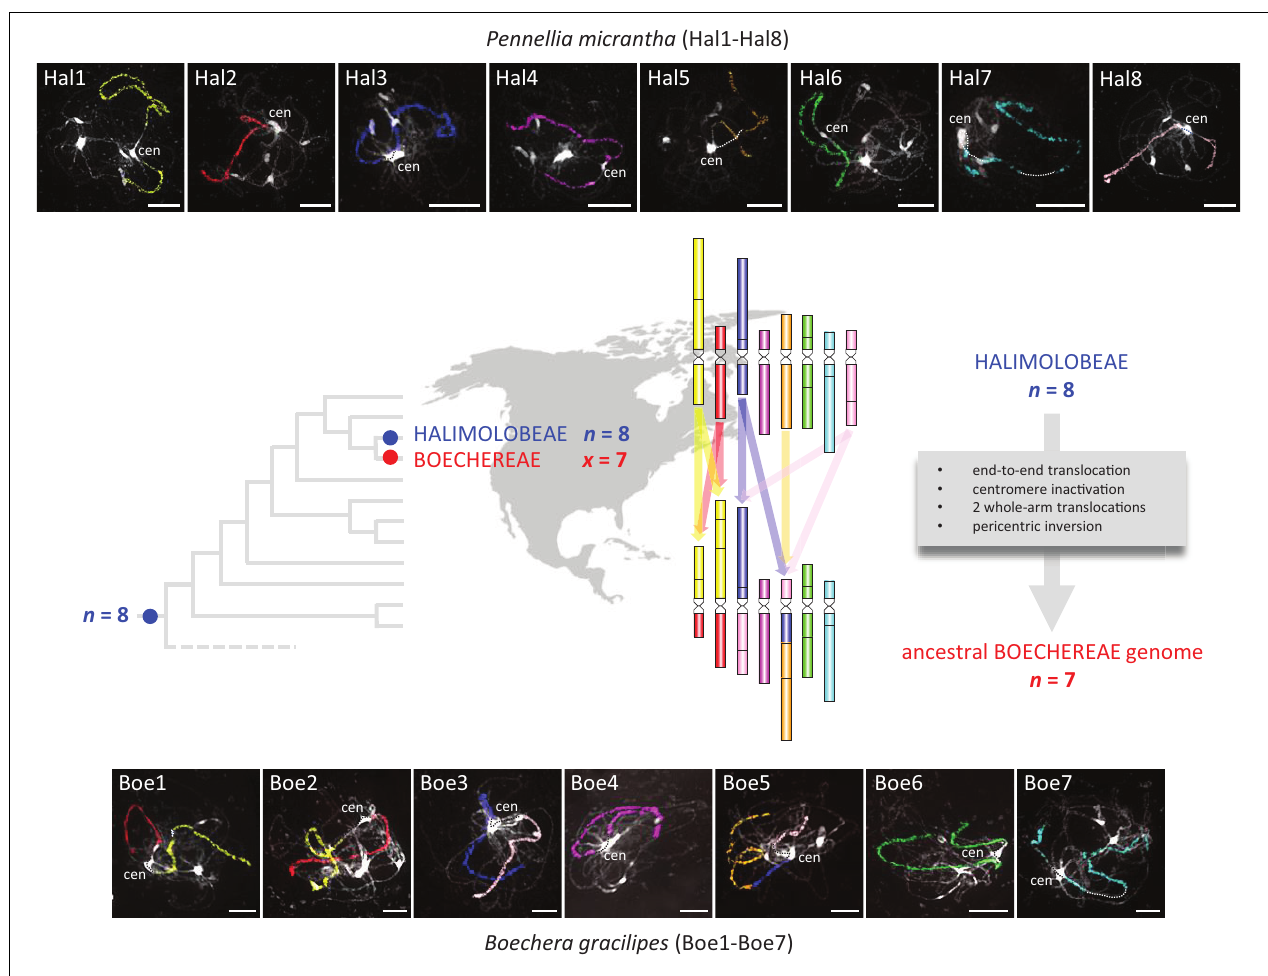
FIGURE 3 | The inferred origin of the ancestral Boechereae genome and painted chromosomes of Pennellia micrantha (Hal1–Hal8) and Boechera gracilipes (Boe1–Boe7). The ancestral Boechereae genome ( n = 7) originated from a Halimolobeae-like genome ( n = 8) through descending dysploidy mediated by an end-to-end translocation accompanied by a centromere inactivaton, two additional reciprocal translocations and a pericentric inversion (see Figure 4 for more details). In the CCP images, different colors correspond to the eight ancestral chromosomes (AK1–AK8) in the Ancestral Crucifer Karyotype (Lysak et al., 2016), whereas capital letters refer to 22 genomic blocks (A to X). A. thaliana BAC clones defining each BAC contig/painting probe in Pennellia and Boechera are listed in Supplementary Tables S2, S3 , respectively. Chromosomes were counterstained by DAPI. The fluorescence signals of the painting probes were captured as black and white photographs, and the signals were then pseudocolored to match the eight chromosomes of the ACK. Scale bars, 10 µ